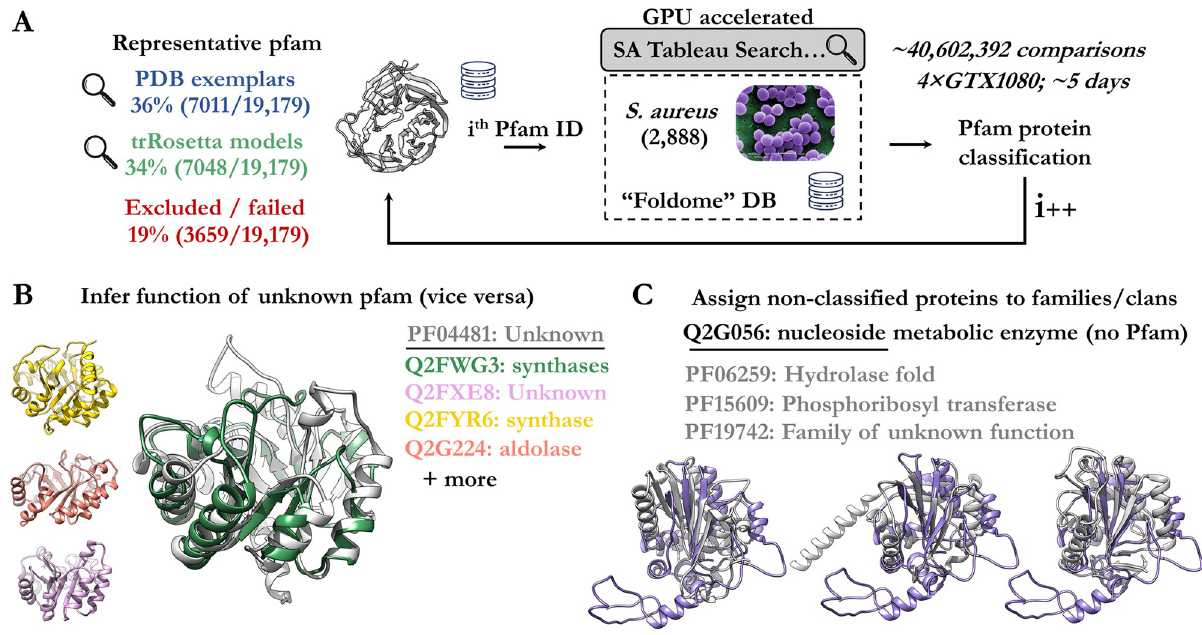
Fig 3. Proteome-wide search and classification of Pfam groups. a. Overview of analysis, firstly search models representing pfam entries were curated from either trRosetta or the PDB. These were each searched against the entire S . aureus foldome to identify matches. The final output was filtered by expectation value. b . Select examples of S . aureus enzymes classified into Pfam category PF04481. This Pfam category previously had unknown role or function. c. The uncategorised protein (Q2G056) is homologous to different Pfam groups with similar enzymatic function (PF06259, PF15609,